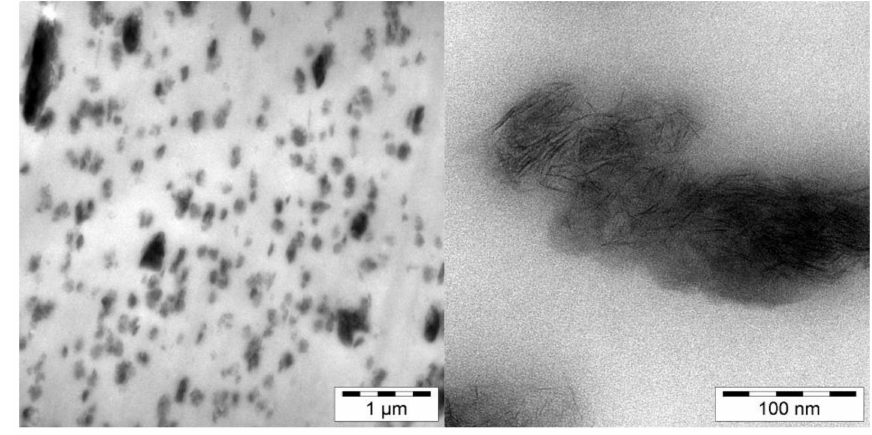
Figure 3. TEM images of a